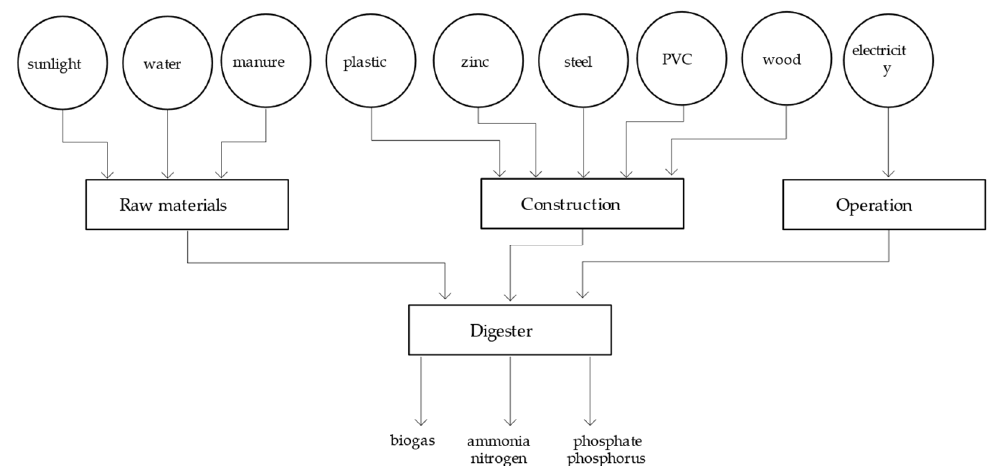
Figure 4. System diagram of the biogas system.